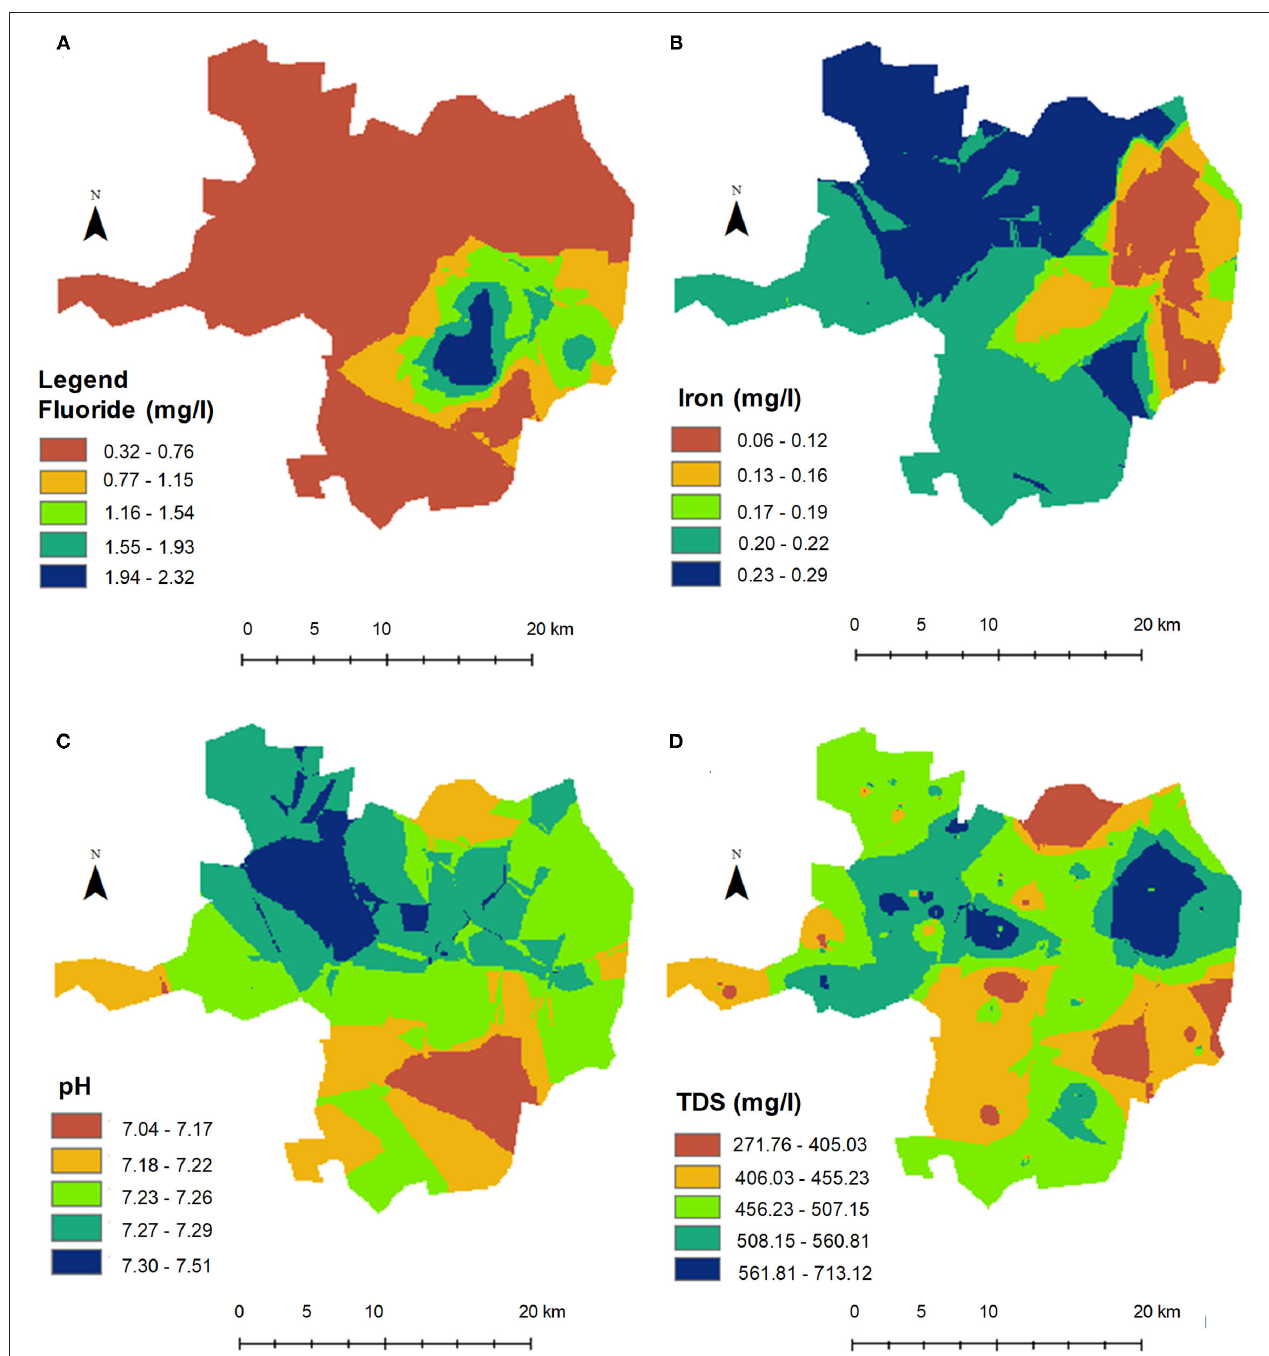
FIGURE 3 | Geospatial maps of groundwater quality: (A) fluoride, (B) iron, (C) pH, and (D) TDS based on kriging interpolation of field observations.